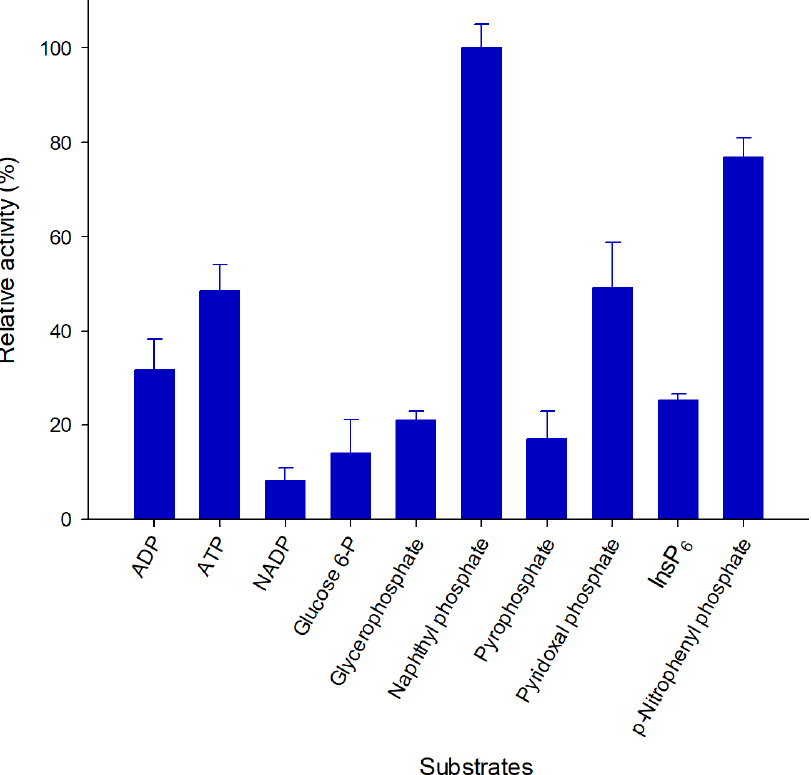
Figure 5. Substrate specificity of Pho16B. Relative activity of Pho16B was measured at 10 mM substrate concentration. All measurements were performed in triplicate and under optimal pH and temperature conditions for enzyme activity. Specific activity values are expressed as percentages of the highest relative activity (13.89 U/mg).